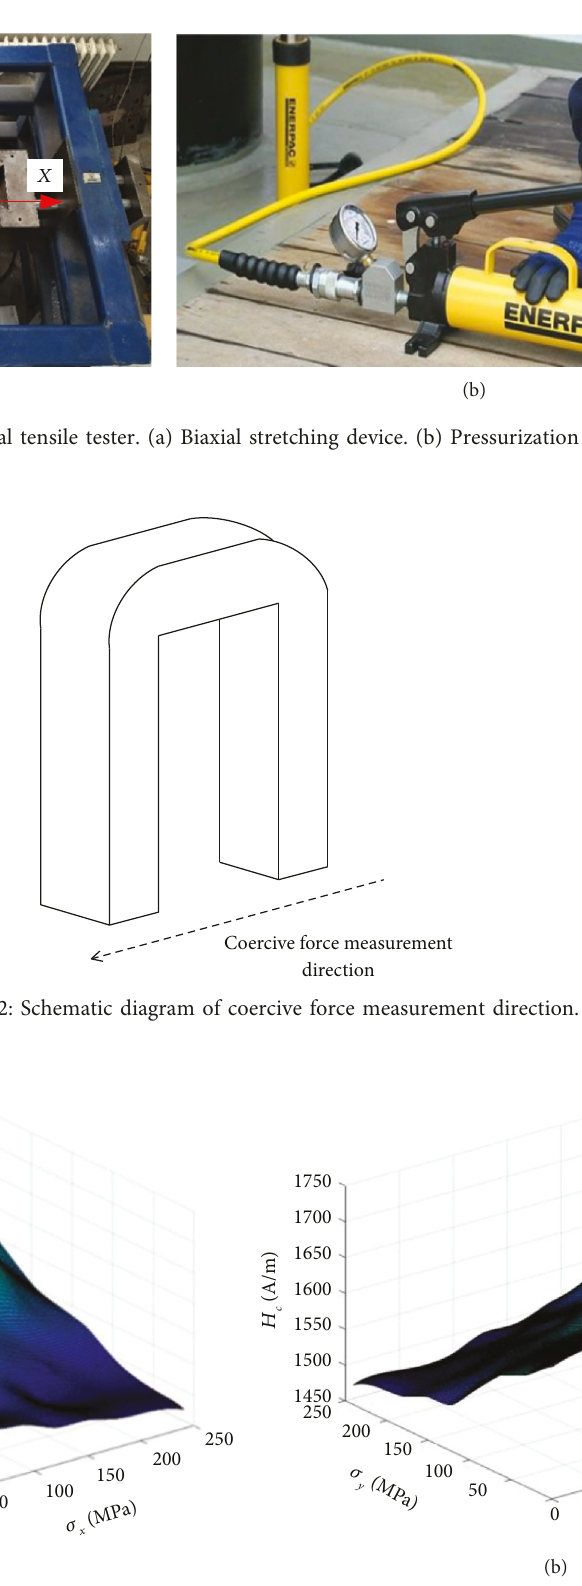
Figure 13: Three-dimensional diagram of test data of test piece 1. (a) Relation between coercive force and stress in X direction. (b) Relationship between coercive force and stress in Y direction.